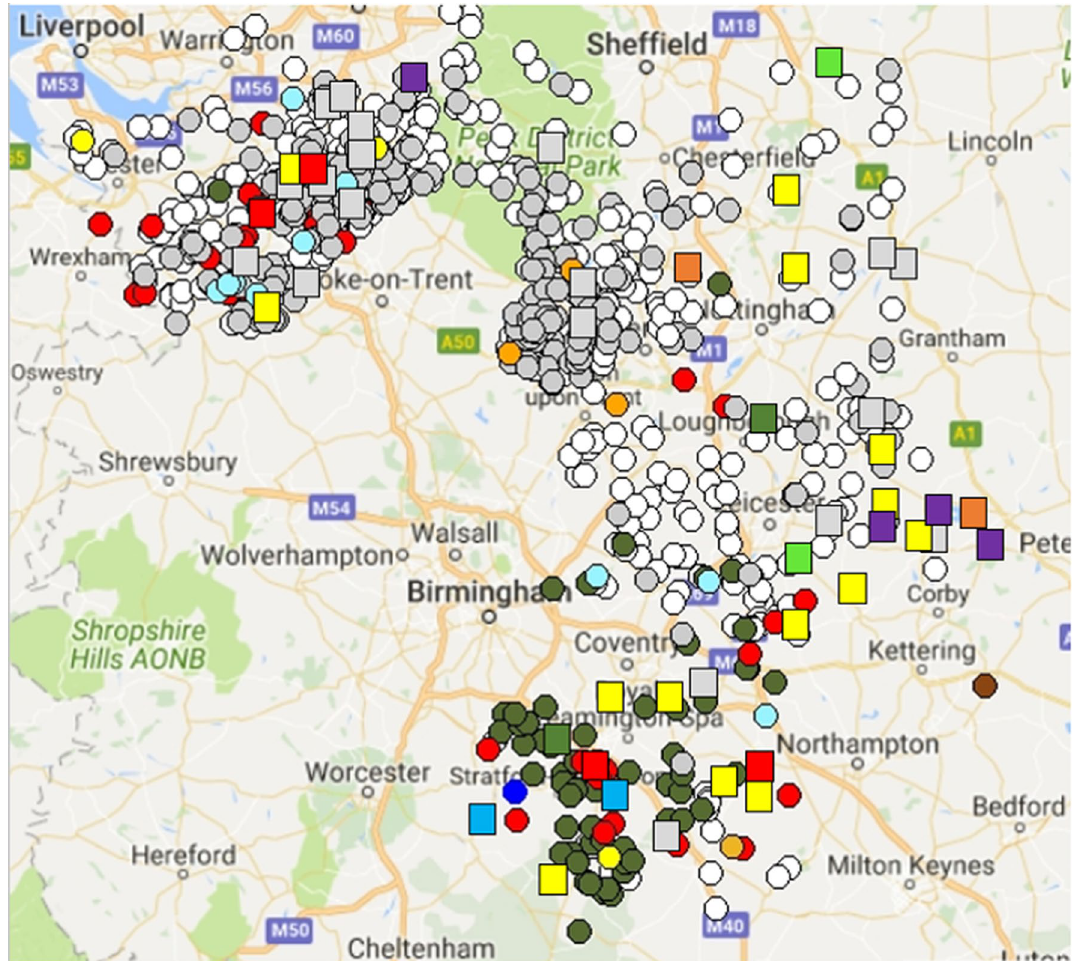
Figure 3. Overall distribution of spoligotypes of MTC isolates from northern EDGE Area cattle (circles) and badgers (squares) key: grey SB0129, red SB0263, blue SB0140, olive green SB0272, gold SB1016, orange SB1016, chocolate SB1414, green SB1512, yellow rare/untypable, purple M. microti. Cattle breakdowns with no known spoligotype are shown as white circles; these are usually breakdowns defined by skin tests but without MTC being cultured for typing. (Original map generated in R version 4.1.0 and package RgoogleMaps 40